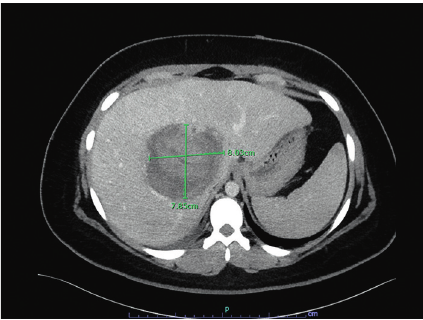
Figure 3: CT scan of the abdomen performed the next day after embolization showing the decrease in the dominant lesion size to 8.0 × 7.9cm.